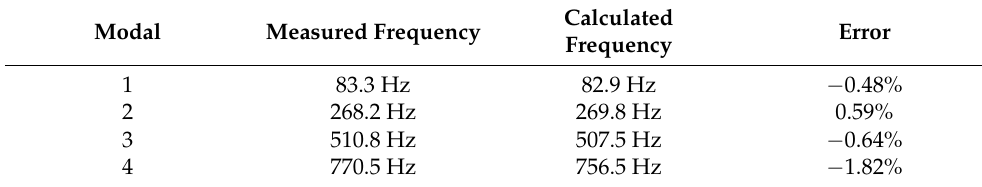
Table 1. Measured and simulated modal